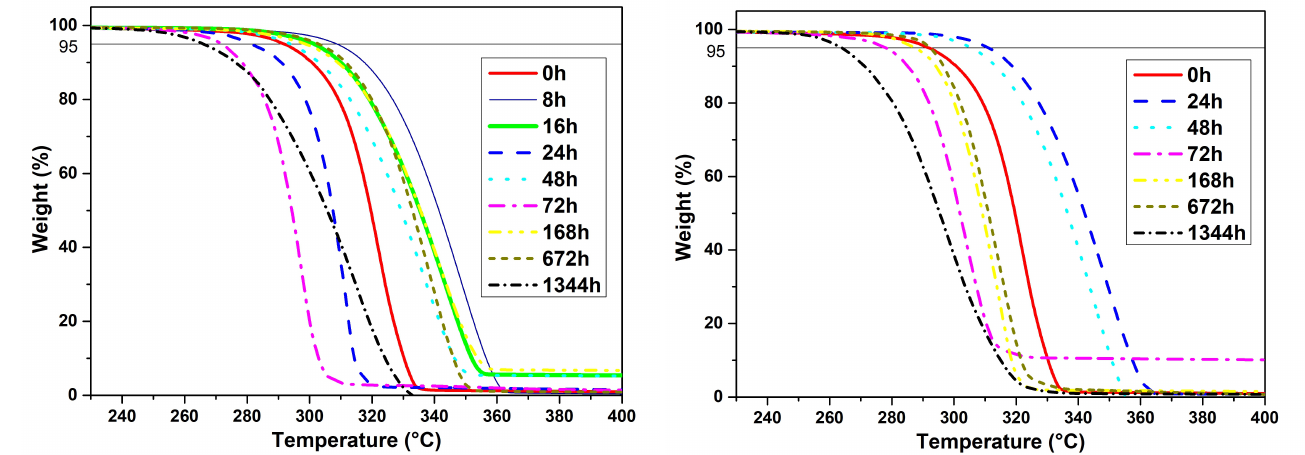
Figure 3. TGA curves of PLA specimens after thermal aging ( left ) and hydrothermal aging ( right ).